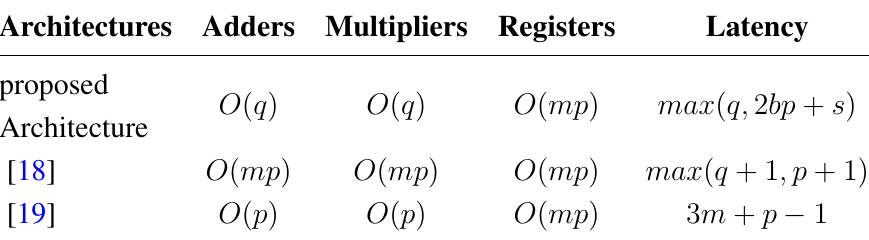
Table 1. Performance analysis of various architectures for GHA